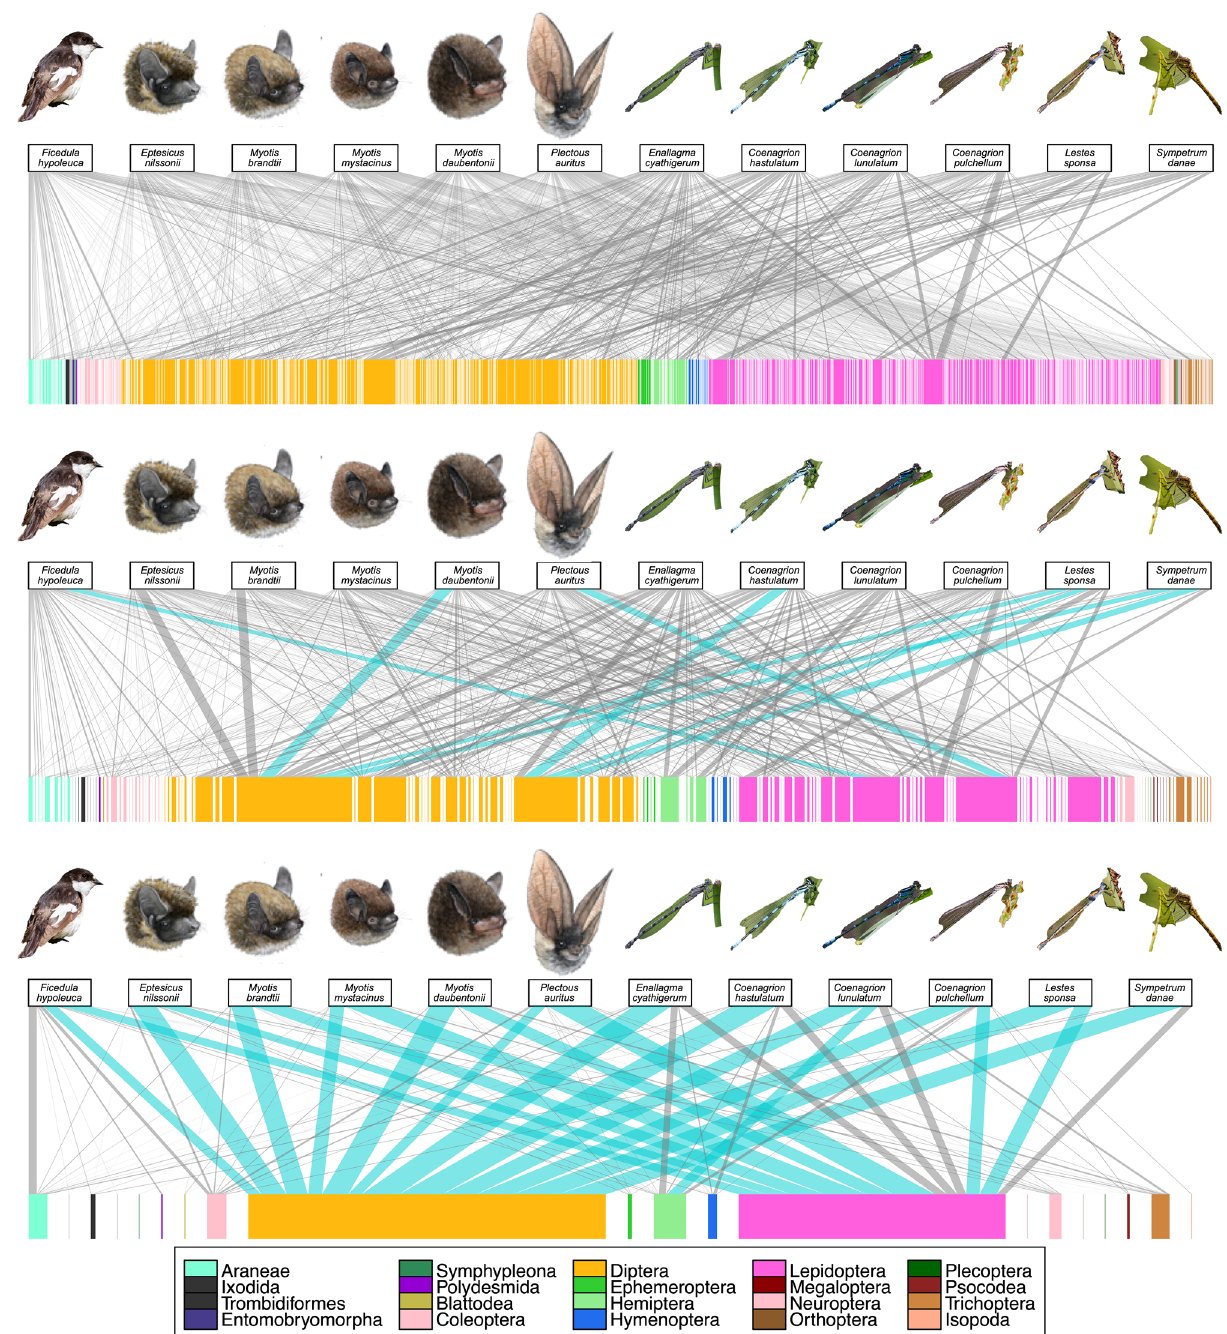
Figure 1. Food webs of twelve different insectivorous predator species (representing three different guilds) and their prey. The diets of three predator guilds: a bird, bats, and dragonflies sensu lato (including all odonates) are compared at three levels of taxonomic resolution: the prey species (top), the prey family (middle), and the prey order (bottom). The pictures in the upper row represent predators in each web and the blocks in the lower row the prey species. The prey is coloured by taxonomic order, as illustrated in the legend below the web. A line connecting a predator with a prey represents a predation record detected by molecular tools, and the thickness of the line represents the relative proportion of each predation record. For each predator, the prey interactions that correspond to at least 20% of the total diet are highlighted as turquoise. For details on methods and original data, including full prey species list, see Supplemental Text 3: Additional results. Photo credits: Maija Laaksonen (bat drawings), Kari Kaunisto (bird and dragonfly